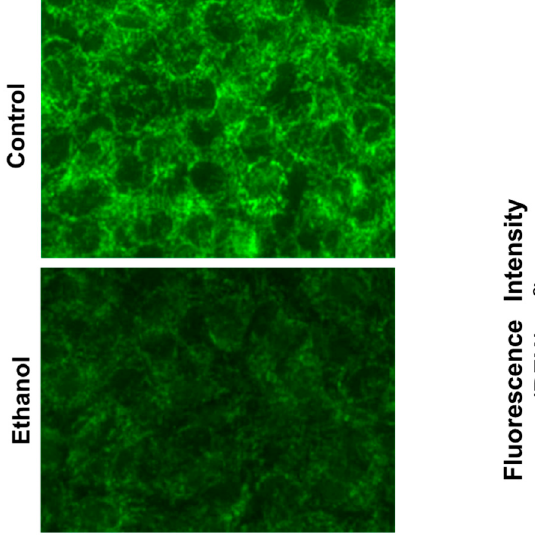
Figure 8. Ethanol decreased the protein expression of B0AT1 in IEC-18 cells. ( a ) Western blot analysis of B0AT1 protein expression in whole cell homogenates from control and ethanol-treated cells. The blots show a representative sample used for densitometric quantification. ( b ) Densitometric quantification of B0AT1 protein expression was significantly decreased in whole cell homogenates after one-hour exposure of ethanol (* p < 0.05, n = 6). ( c ) Western blot analysis of BBM B0AT1 protein expression from control and ethanol-treated cells. The blots show a representative sample used for densitometric quantification. ( d ) Densitometric analysis of B0AT1 protein expression was significantly decreased in the BBM fraction after one-hour exposure of ethanol (* p < 0.05, n = 4). All lanes were run on the same membrane. The error bars represent the SEM. To assure equivalence of loading, the blots were normalized with anti-ezrin antibodies.